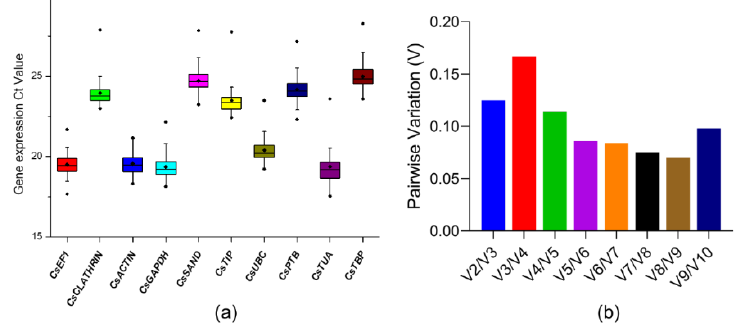
Figure 3. The selection and validation of endogenous reference genes. ( a ) Expression profiles of 10 candidate reference genes (RGs) in C. sinensis . The Ct mean value refers to the short bar; the box represents the 25th–75th percentiles, and the dark spots refer to extreme outliers; ( b ) Optimal number of reference genes for the normalization of C. sinensis under JA-Ile-macrolactones treatments. The pairwise variation (Vn/n + 1) was calculated by geNorm software to determine the optimal number of RGs required in the analysis of qPCR. Another RG will not significantly improve normalization when values are less than 0.15.